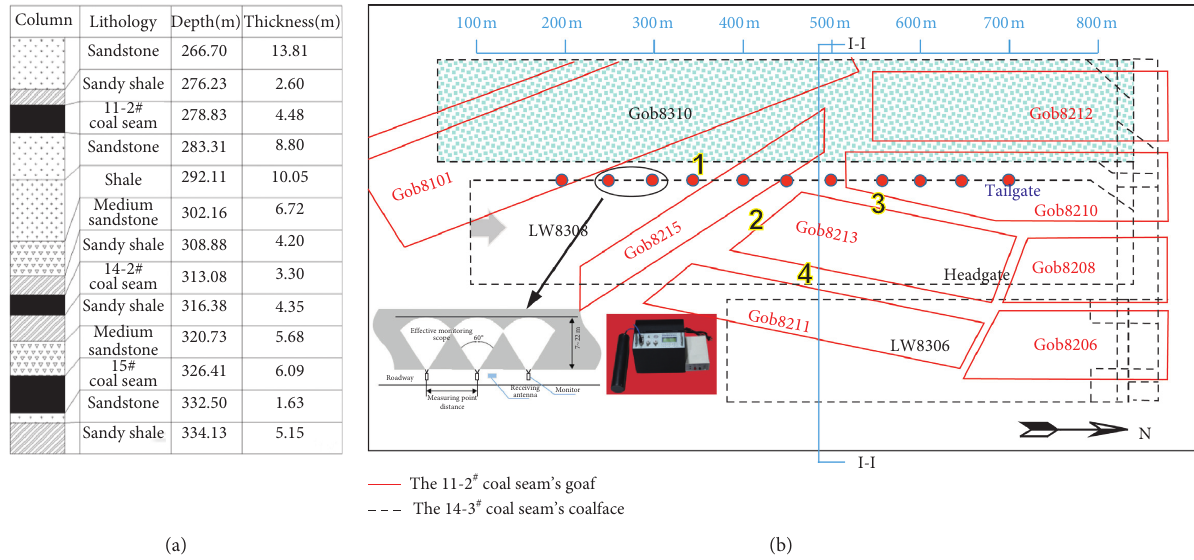
Figure 5: (a) Borehole column map; (b) Comparison map of 8308 working face and 11-2 coal seam